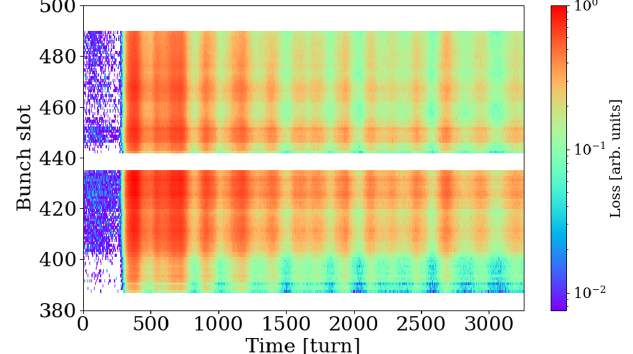
FIG. 15. Bunch-by-bunch losses recorded by dBLM acquis- ition mode 2 during one scan step in fill 7392 for beam 1 (details in Table III).